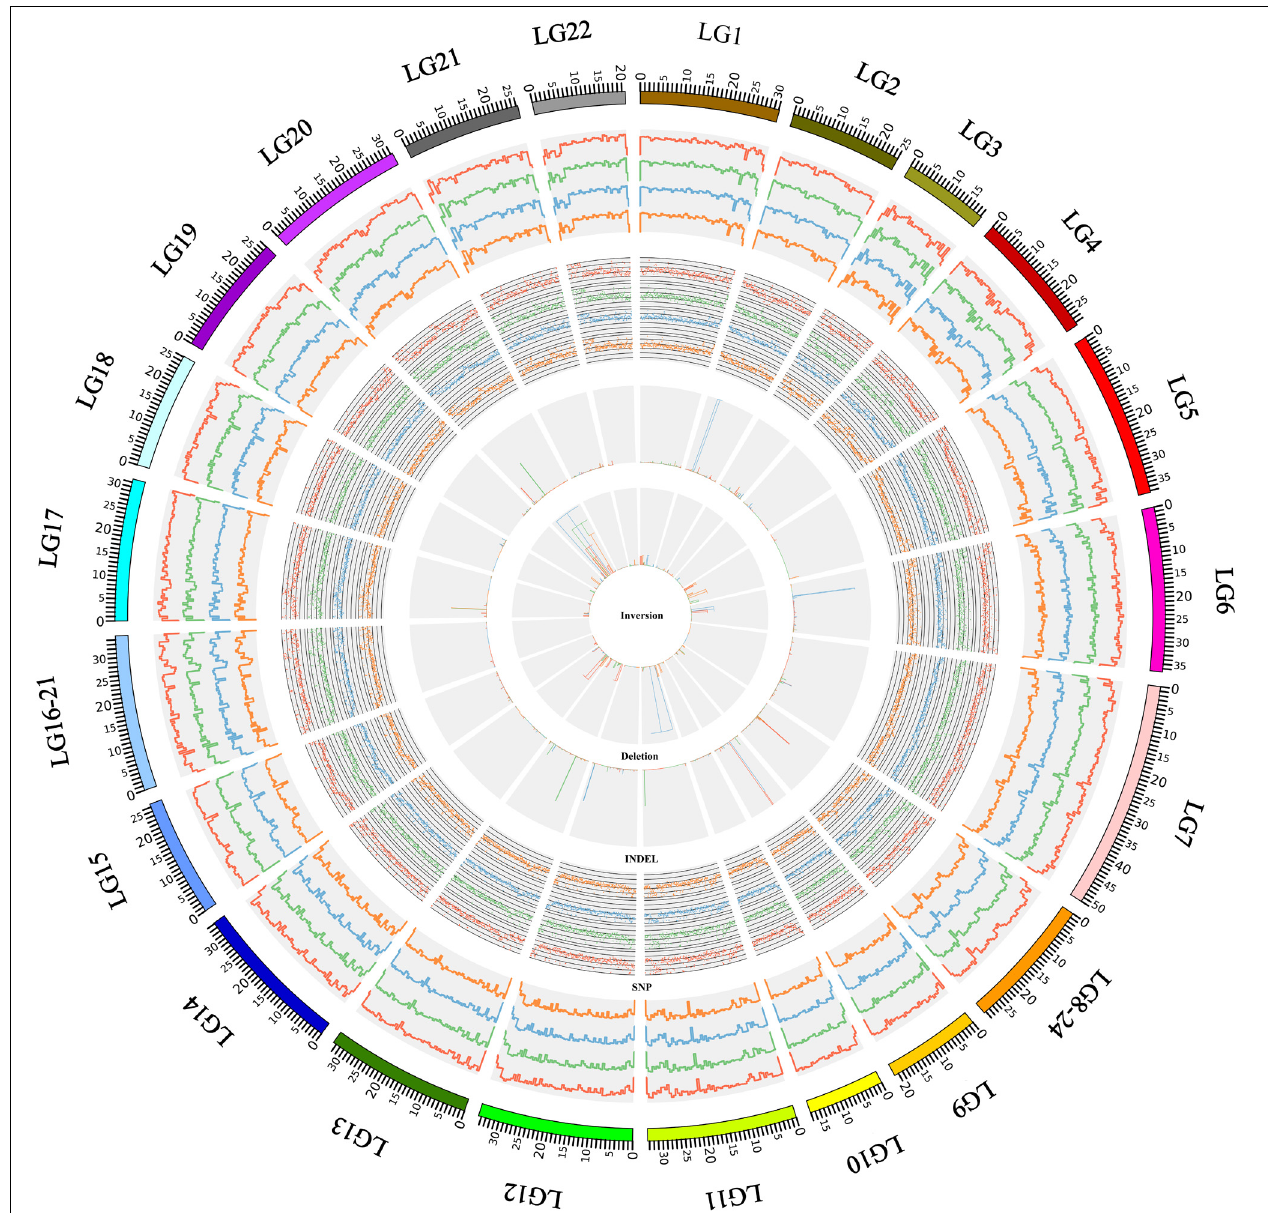
FIGURE 1 | The distribution of genomic variation in the African cichlid genomes. This figure shows an overview of the SNPs, indels, inversions, and deletions that were identified in this study. The most outer ring showed the chromosomal ideogram in a clockwise orientation. The panels from outside to inside summarized the SNP density, indel density, and the location of the inversions and deletions, which were identified in